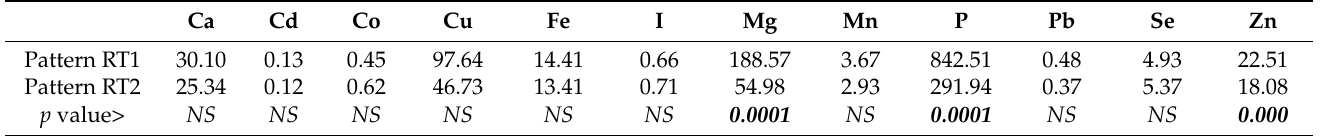
p ≤ 0.05 considered significantly differ between means. NS = Not Significant. All significant values are in